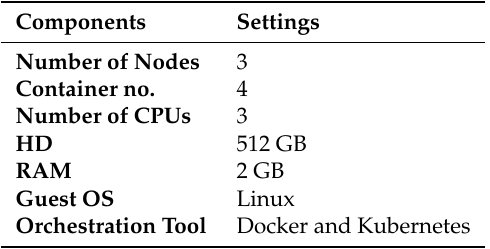
Table 3. Configuration of cluster nodes and